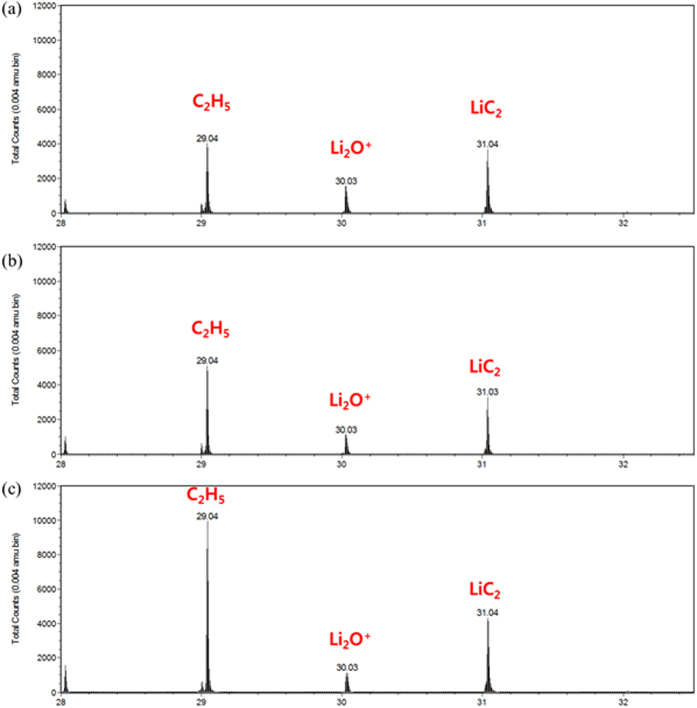
ToF-SIMS spectra showing peaks for Li2O+ and LiC2+ in the (a) pristine sample, (b) acid-evaporated NCM, and (c) water-evaporated NCM.